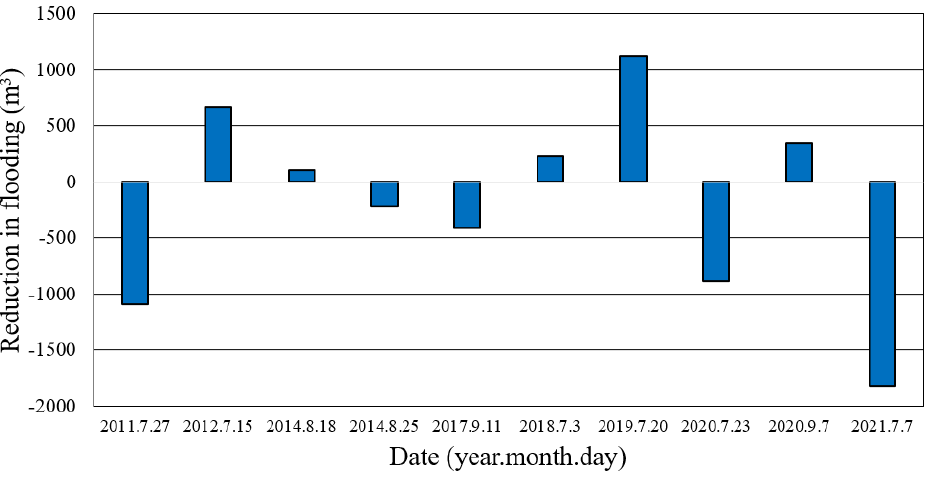
Figure 10. Flood reduction at Location 2.